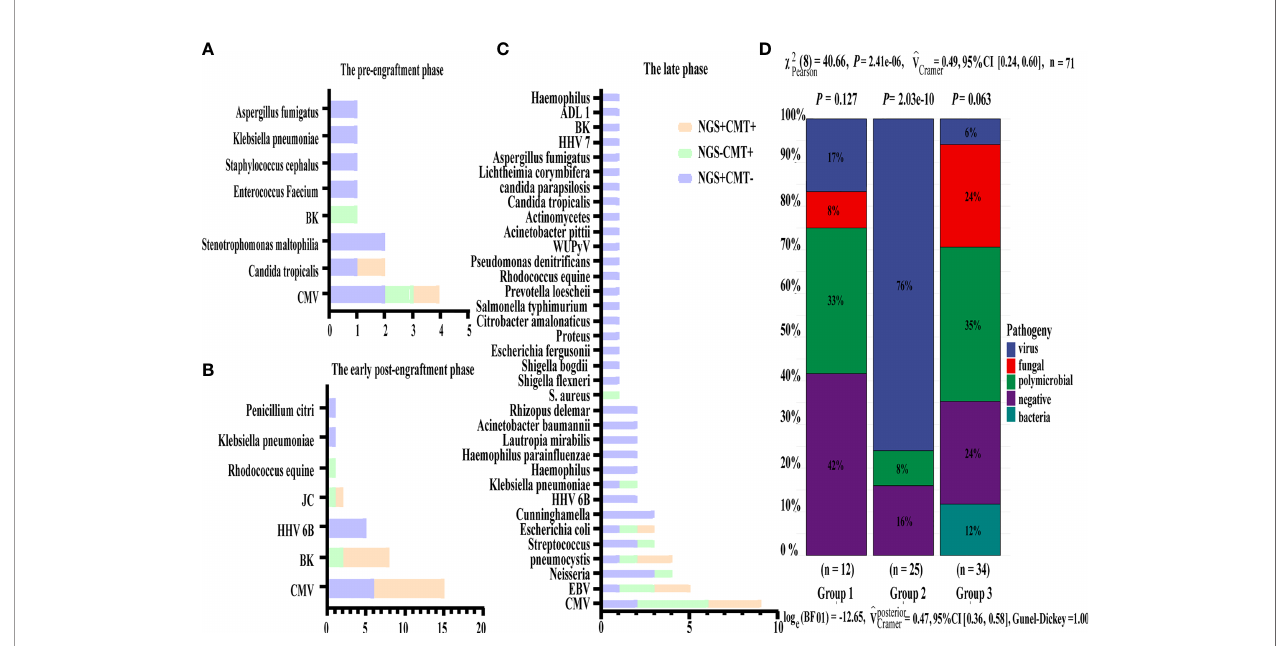
FIGURE 3 | Distribution of pathogens identi fi ed in three group using CMT versus NGS. (A – C) Respectively showed the number of subjects in whom each causative microbe was detected in three group. Orange bars indicate microbes detected by CMT and also predicted as pathogens by NGS (CMT+NGS+). Purple bars indicate microbes detected by NGS only (CMT − NGS+). Green bars indicate the number of cases with microbes detected only by CMT (CMT+NGS − ). (D) Distribution of pathogens was shown from patients in three group. Virus infection accounted for 76% among group 2 and there were signi fi cant differences in pathogen